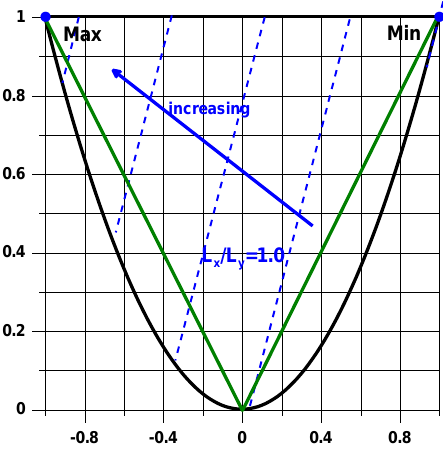
Figure 10. Contours of natural frequencies on the x , y plane for and symmetric laminates—free-clamped (FFFC) plates.